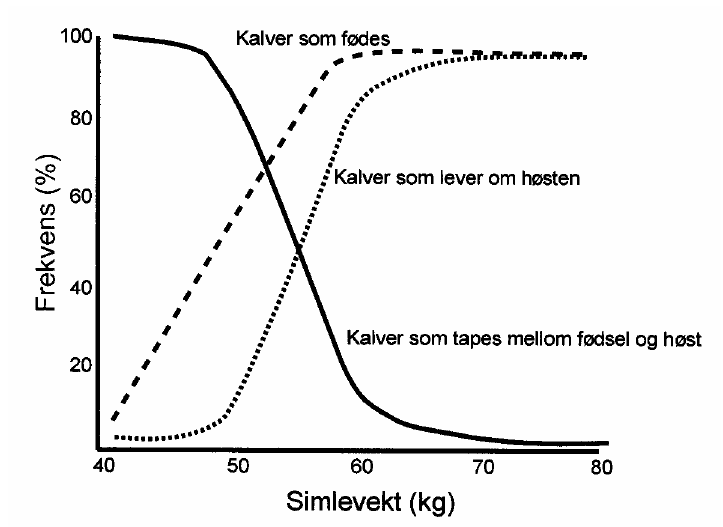
Fig. 1. Skjematisk framstilling av sammenhengen mellom simlenes levendevekt om høsten, kalveprosent og kalvetap fram til høsten (Lenvik, 1988).